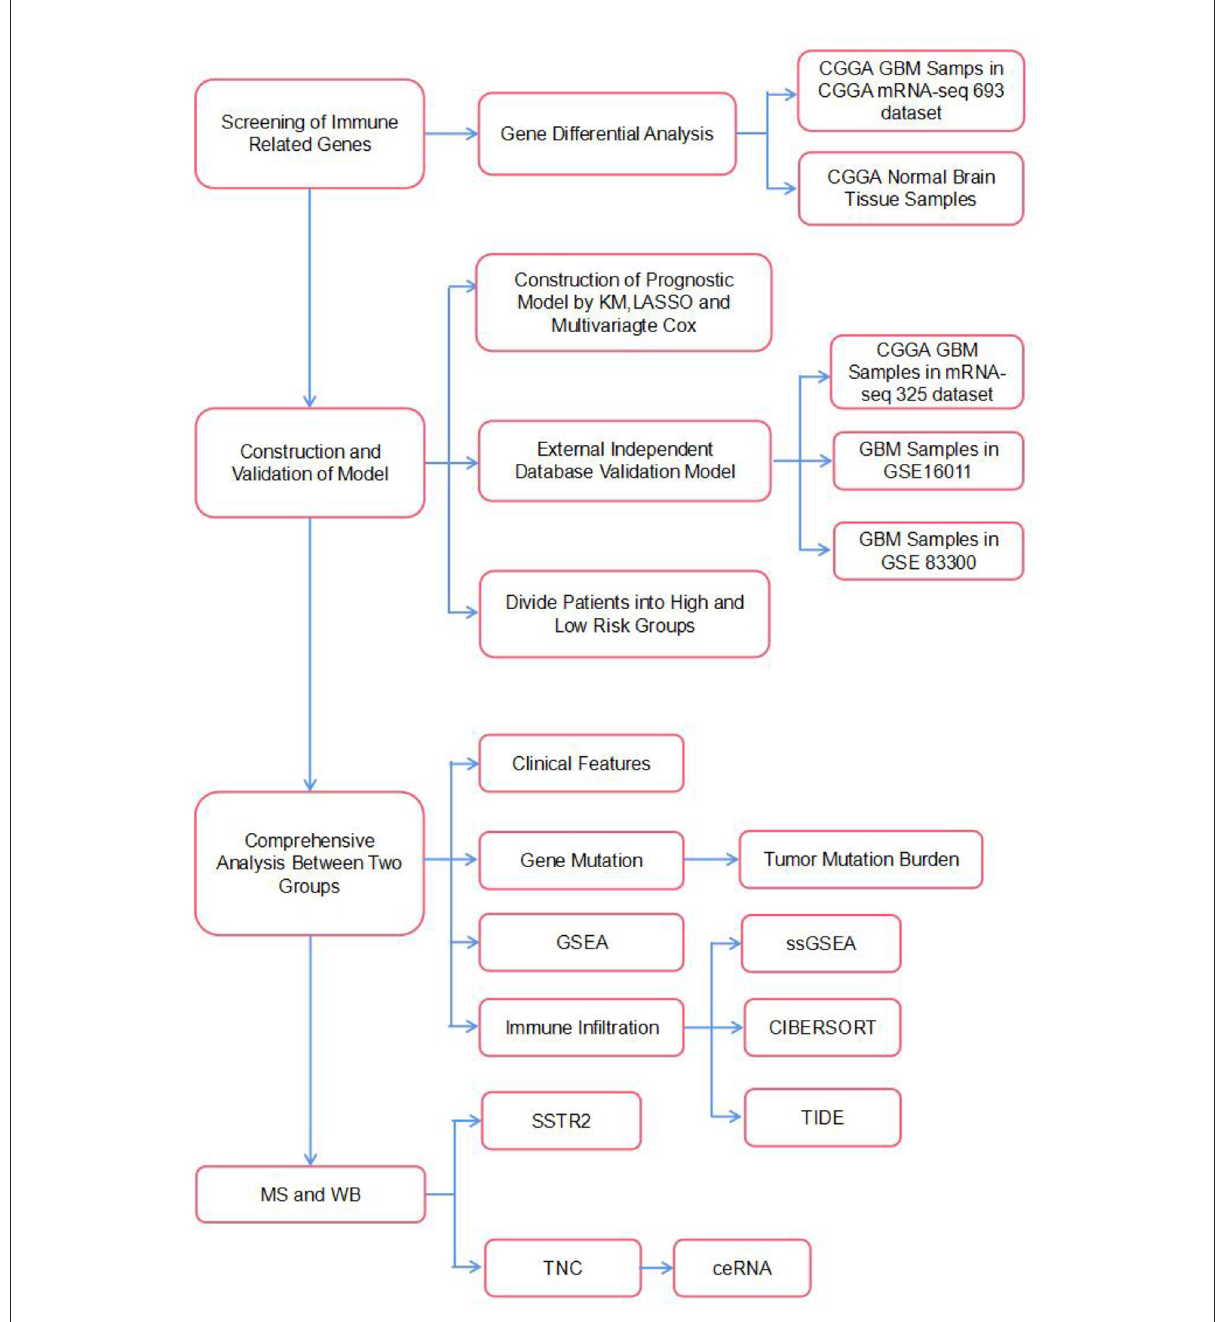
FIGURE1 The flowchart of our